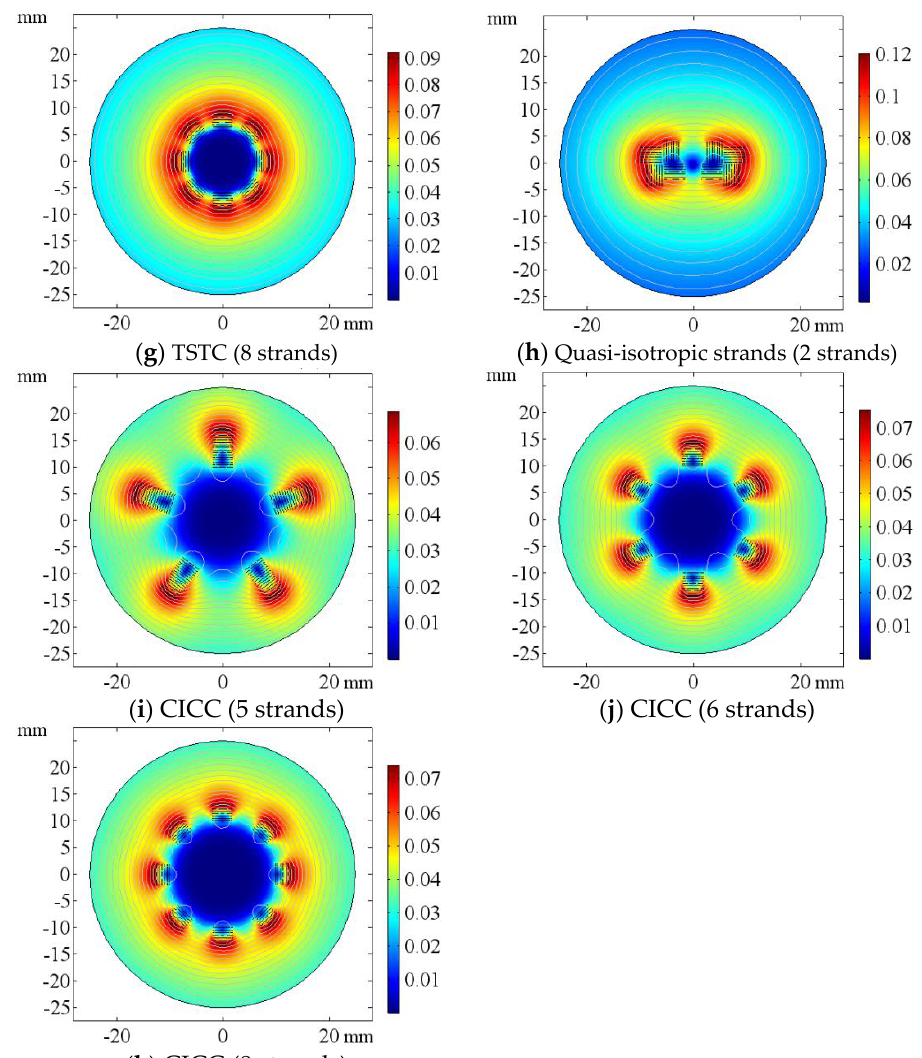
Figure 7. Magnetic field (T) on the surface of superconducting tape.